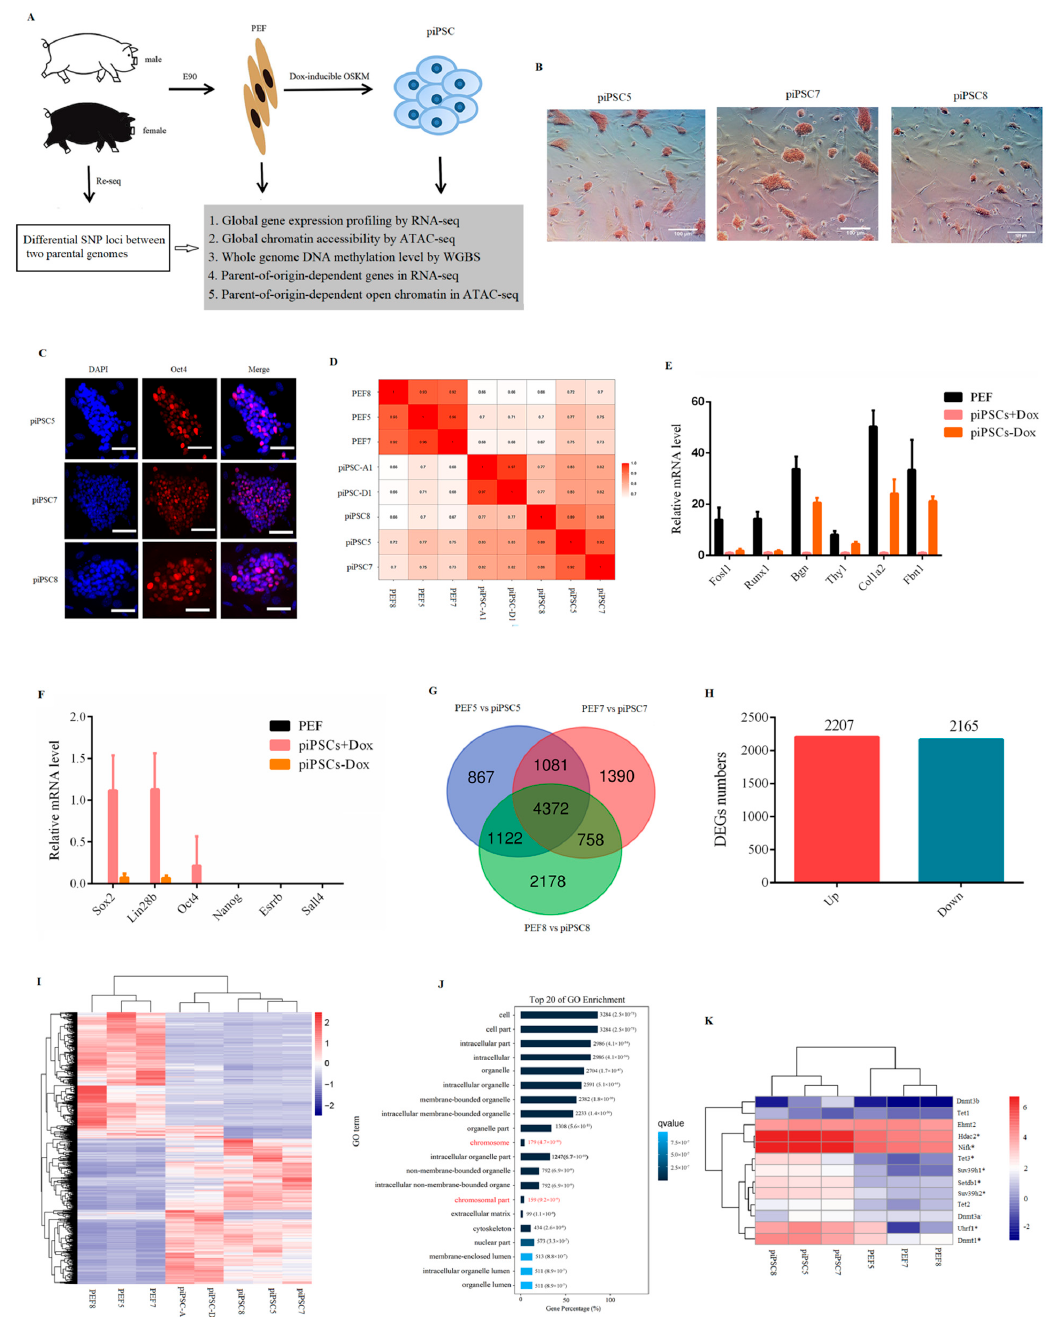
Figure 1. Generation of piPSCs genetically matched with PEFs. ( A ) Schematic for generation of genetically matched piPSCs from PEFs. ( B ) Alkaline phosphatase (AP) staining for three piPSCs. Scale bar, 100 µ m. ( C ) Immunofluorescence analysis for Oct4 in three piPSCs. Nuclei were stained with DAPI. Scale bars, 100 µ m. ( D ) Heatmap analysis for PEFs and piPSCs acquired in this study as well as piPSCs acquired in other groups based on global gene expression. ( E ) Relative mRNA level of PEF-specific genes. ( F ) Relative mRNA level of pluripotency genes. ( G ) Venn analysis of differential expressed genes between three groups. ( H ) Numbers of downregulated genes and upregulated genes between three groups. ( I ) Heatmap cluster for three PEFs and three piPSCs acquired in this study as well as two piPSCs acquired in other groups based on 4372 DEGs. ( J ) Top 20 of GO analysis terms for 4372 DEGs. ( K ) Heatmap analysis showing the expression level of epigenetic modification-related genes based on RNA-seq data. * p < 0.05 between PEFs and